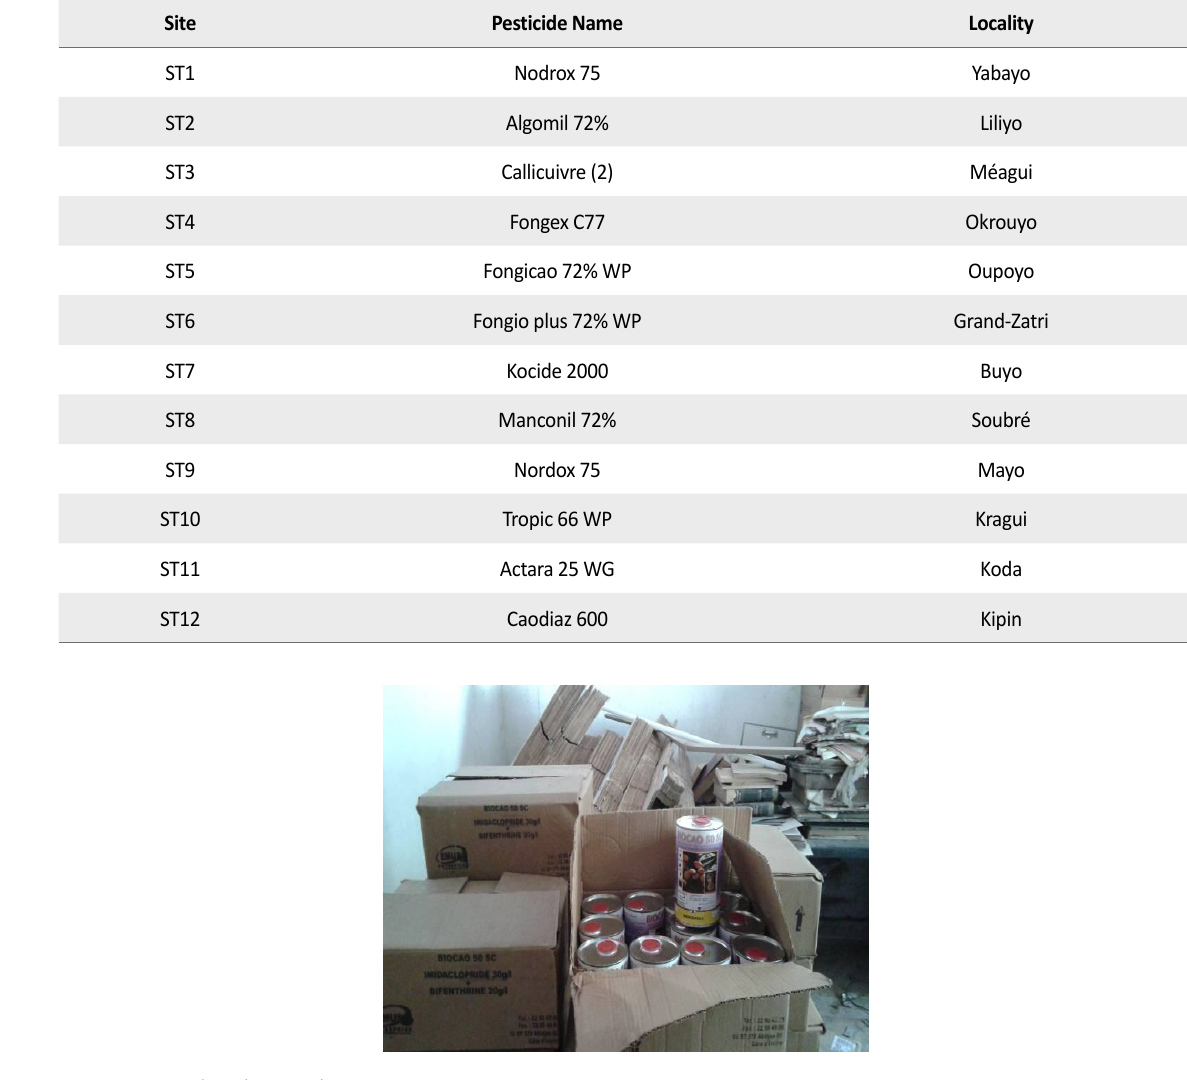
Figure 3. Some listed pesticides